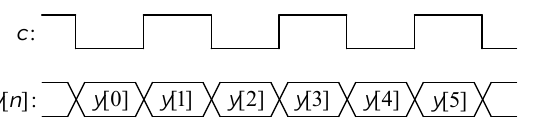
Figure 10. The time diagram of control signal c in the proposed 1 ‐ D inverse 5/3 filter. The proposed 1 ‐ D inverse DWT 5/3 filter provides output data samples for even indexes n = 2 p and odd indexes n = 2 p + 1 in an interleaved fashion, as shown in Figure 11.